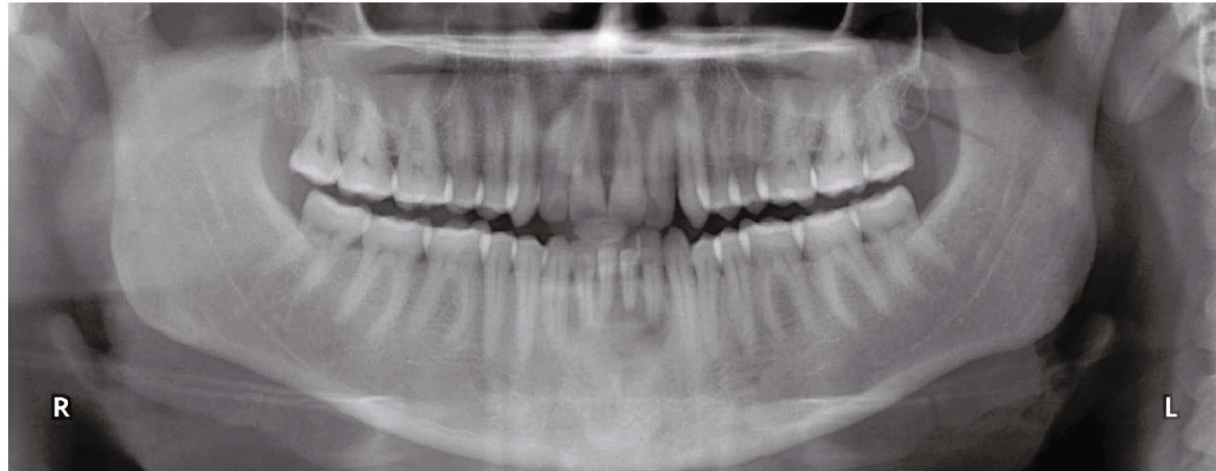
Figure 1: Orthopantomogram showing the mandibular radiolucent